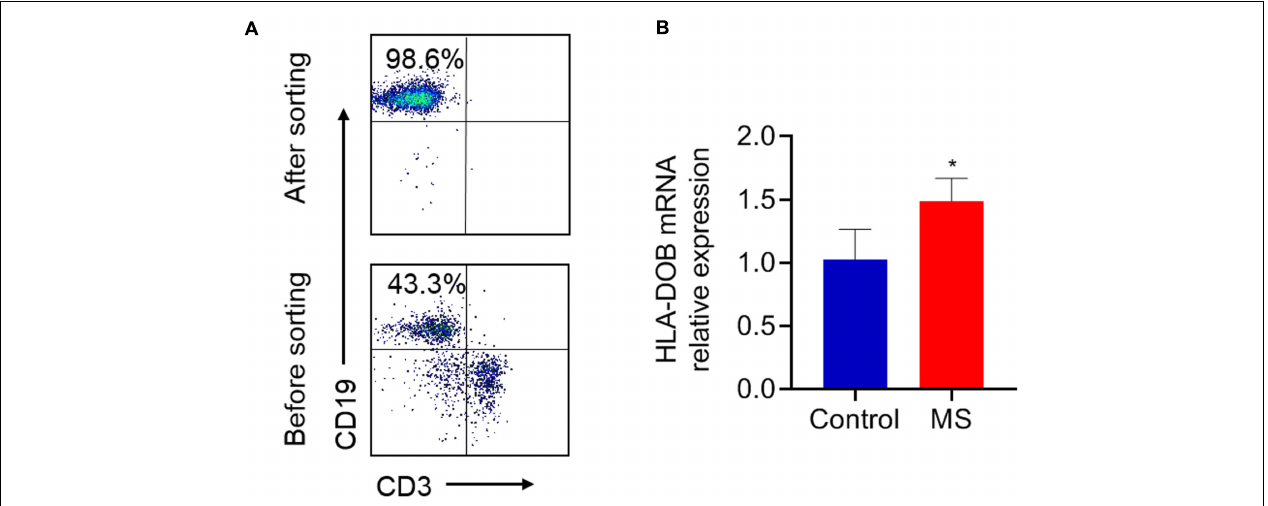
FIGURE 1 | The expression levels of HLA-DOB gene in MS patients and healthy controls. (A) B lymphocytes (purity ≈ 98%) were collected from the PBMCs of MS patients, as well as healthy controls and sorted by FACS. (B) RT-PCR showed that the mRNA expression of HLA-DOB in MS patients was higher than that in healthy controls. Data are presented as mean ± SEM; * p < 0.05 in contrast with the control group; n = 5 per